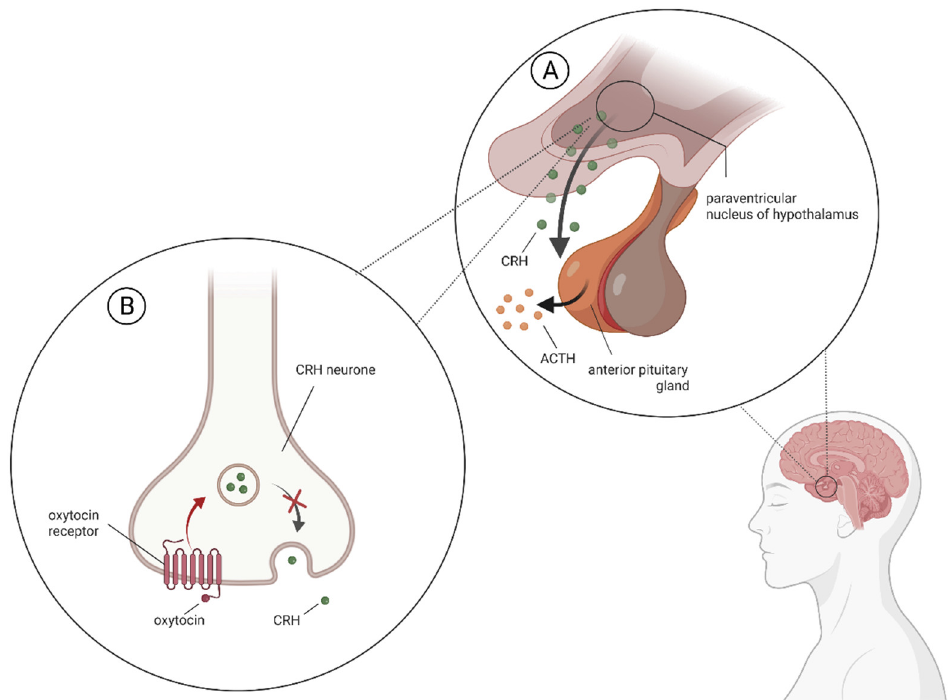
Figure 2. The functioning of the hypothalamic–pituitary–adrenal (HPA) axis in the brain with the oxytocin effect on CRH neurons (created with BioRender.com, accessed on 18 June 2022). ( A ) After a stressor, corticoliberin (CRH—corticotropin-releasing hormone) is released from the paraventricular nucleus (PVN) of the hypothalamus. It acts on the anterior pituitary gland, thereby mediating the release of corticotropin (ACTH—adrenocorticotropic hormone). This hormone leads to the release of glucocorticoids, among others, from the adrenal cortex. ( B ) OXT binds to OXT receptors, located on CRH neurons within the hypothalamus. As a result, there is a reduction in CRH secretion. As a further consequence, components of the HPA axis are affected, potentially contributing to modification of the pathophysiologically dysregulated axis among patients with PTSD.